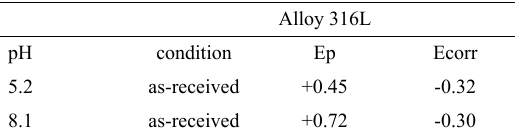
Figure 13 . Optical images of rust on the surfaces of the samples of the 316L steel (a, b), 317L steel (c) and salt particles on the surface of the AL-6XN PLUS™ steel (d) after the exposure test under 5 MPa of CO and 3 MPa of synthetic air at 80 °C for 168 h sprayed with TQ3219 solution. Table. 4. Change of the pitting potential and the corrosion potential measured in V vs Ag/AgCl sat KCl of the alloy 316L.